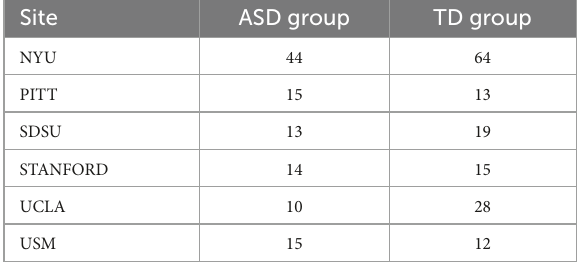
TABLE 1 Sites of participants where T1 images were obtained and corresponding sample